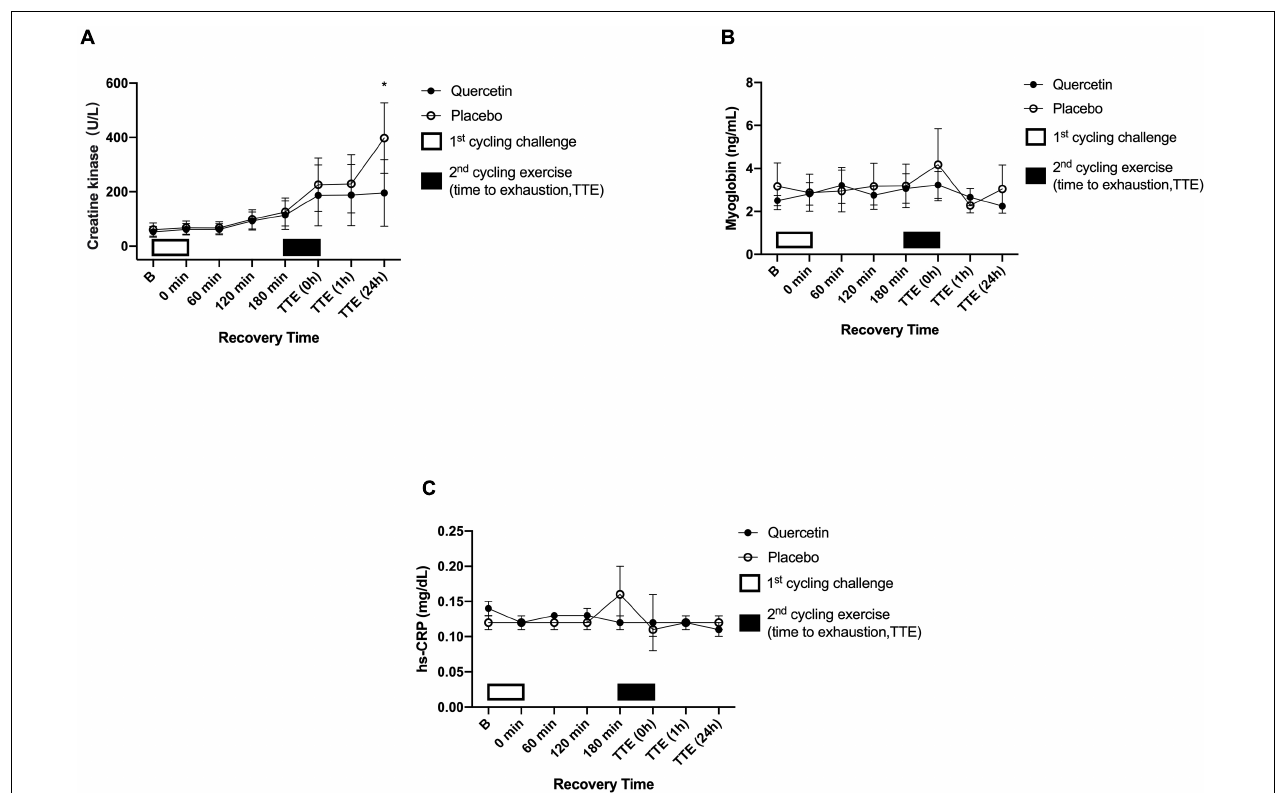
FIGURE 7 | Serum creatine kinase (CK) (A) , myoglobin (B) , and hs-CRP (C) concentrations in (- ◦ -) placebo and (- • -) quercetin trials. B represents before the first cycling challenge. TTE (0 h, 1 h, 24 h): represents immediately, 1-h, and 24-h after the second cycling exercise, respectively. *Significant difference between quercetin and placebo ( p < 0.05). Values are expressed as mean ± SE, N =